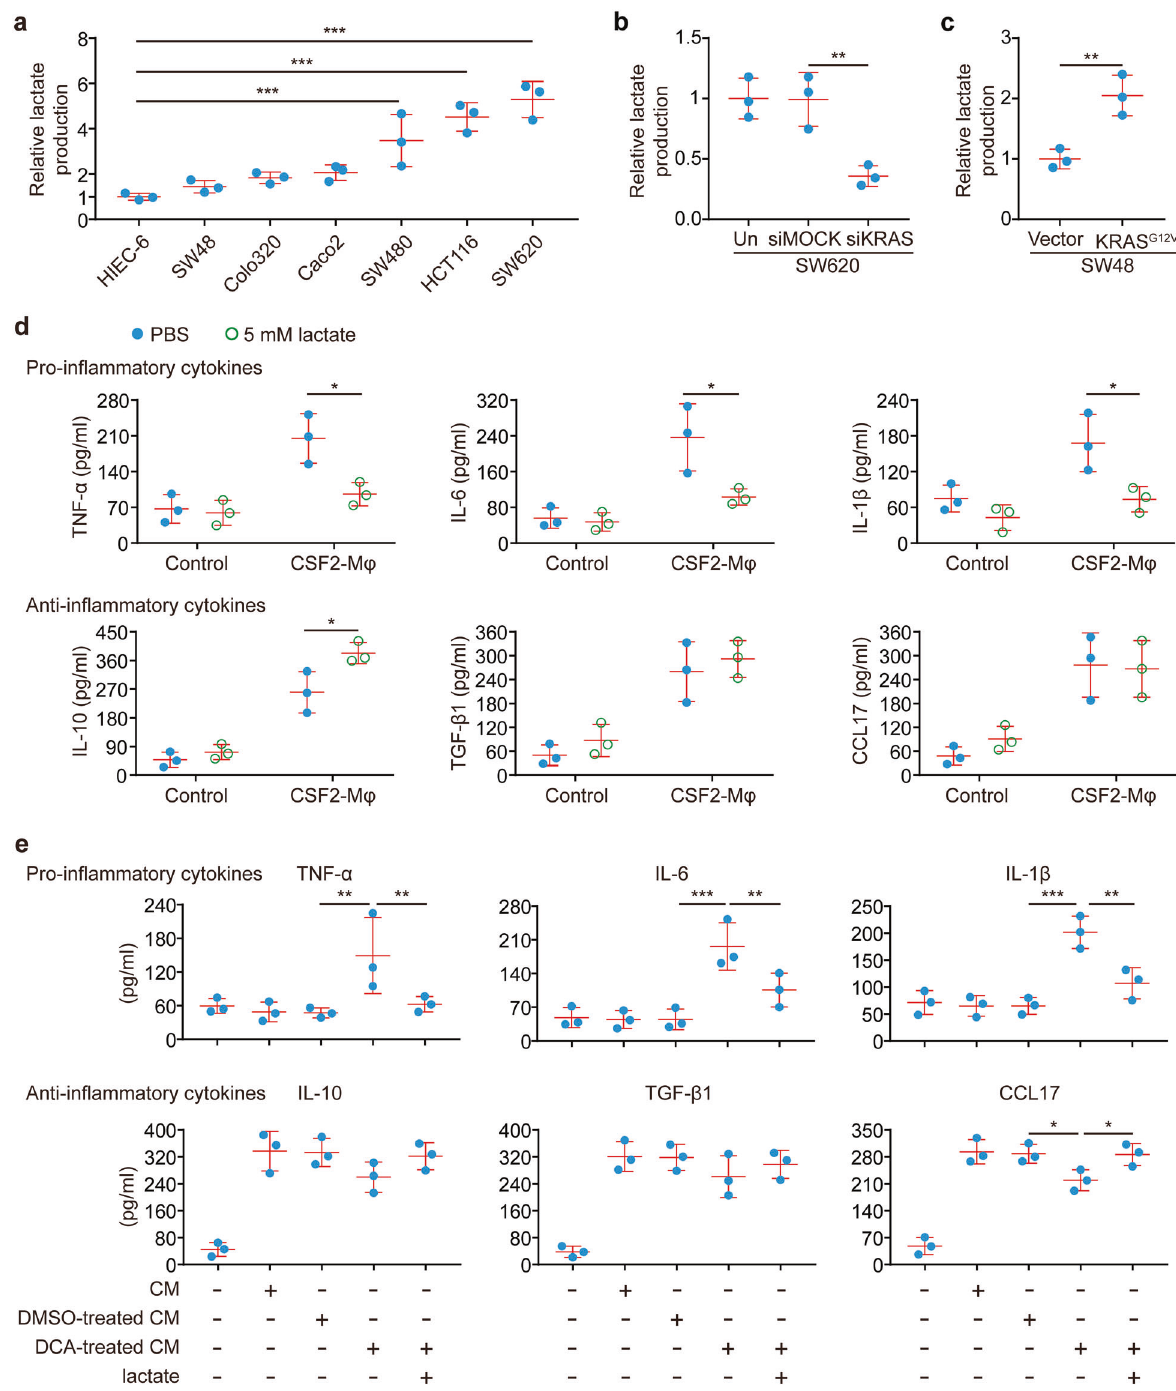
Fig. 5 The pro-in fl ammatory activities of CSF2-activated macrophages are blunted by tumor-derived lactate. a – c Relative lactate production in the media of the indicated cells ( n = 3). d Macrophages were obtained by culture of monocytes in culture medium in the presence or absence of 20 ng/ml CSF2 for 6 days. Afterward, macrophages were cultured in a culture medium with or without 5 mM lactate for 24 h. Cytokine levels in the media were measured by ELISA ( n = 3 independent experiments using macrophages from three different donors). e SW620 cells were cultured in the presence or absence of 2 mM sodium dichloroacetate (DCA) for 72 h. CM was collected after the cells were cultured for another 24 h without DCA. In addition, the lactate level in CM obtained from SW620 cells treated with DCA was adjusted to the levels in untreated SW620 CM by the addition of lactate. Macrophages were obtained by culture of monocytes in culture medium in the presence or absence of the indicated SW620 CM for 6 days. The cytokine concentrations of the macrophages were measured afterward ( n = 3 independent experiments using macrophages from three different donors). * p ≤ 0.05, ** p ≤ 0.01, and *** p ≤ 0.001, by one-way ANOVA ( a , b , e ) or two-tailed Student ’ s t -test ( c , d )